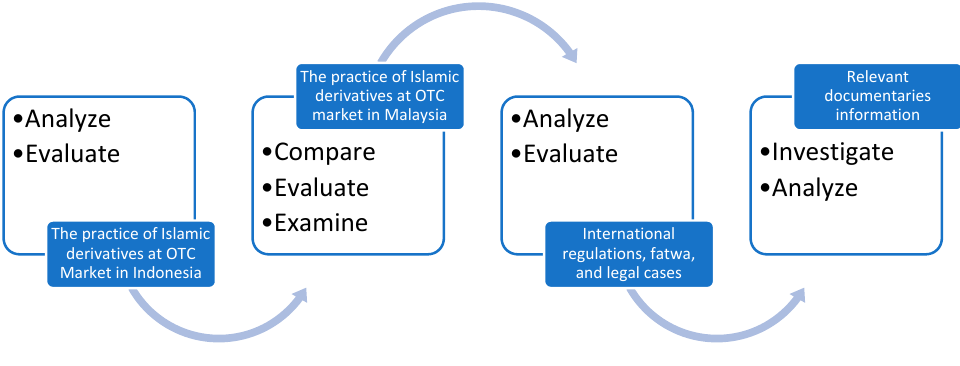
Figure 1. Research Frameworks.